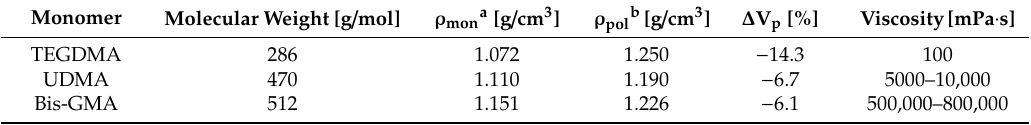
Table 1. Properties of the popular free radical monomers to obtained dental composites